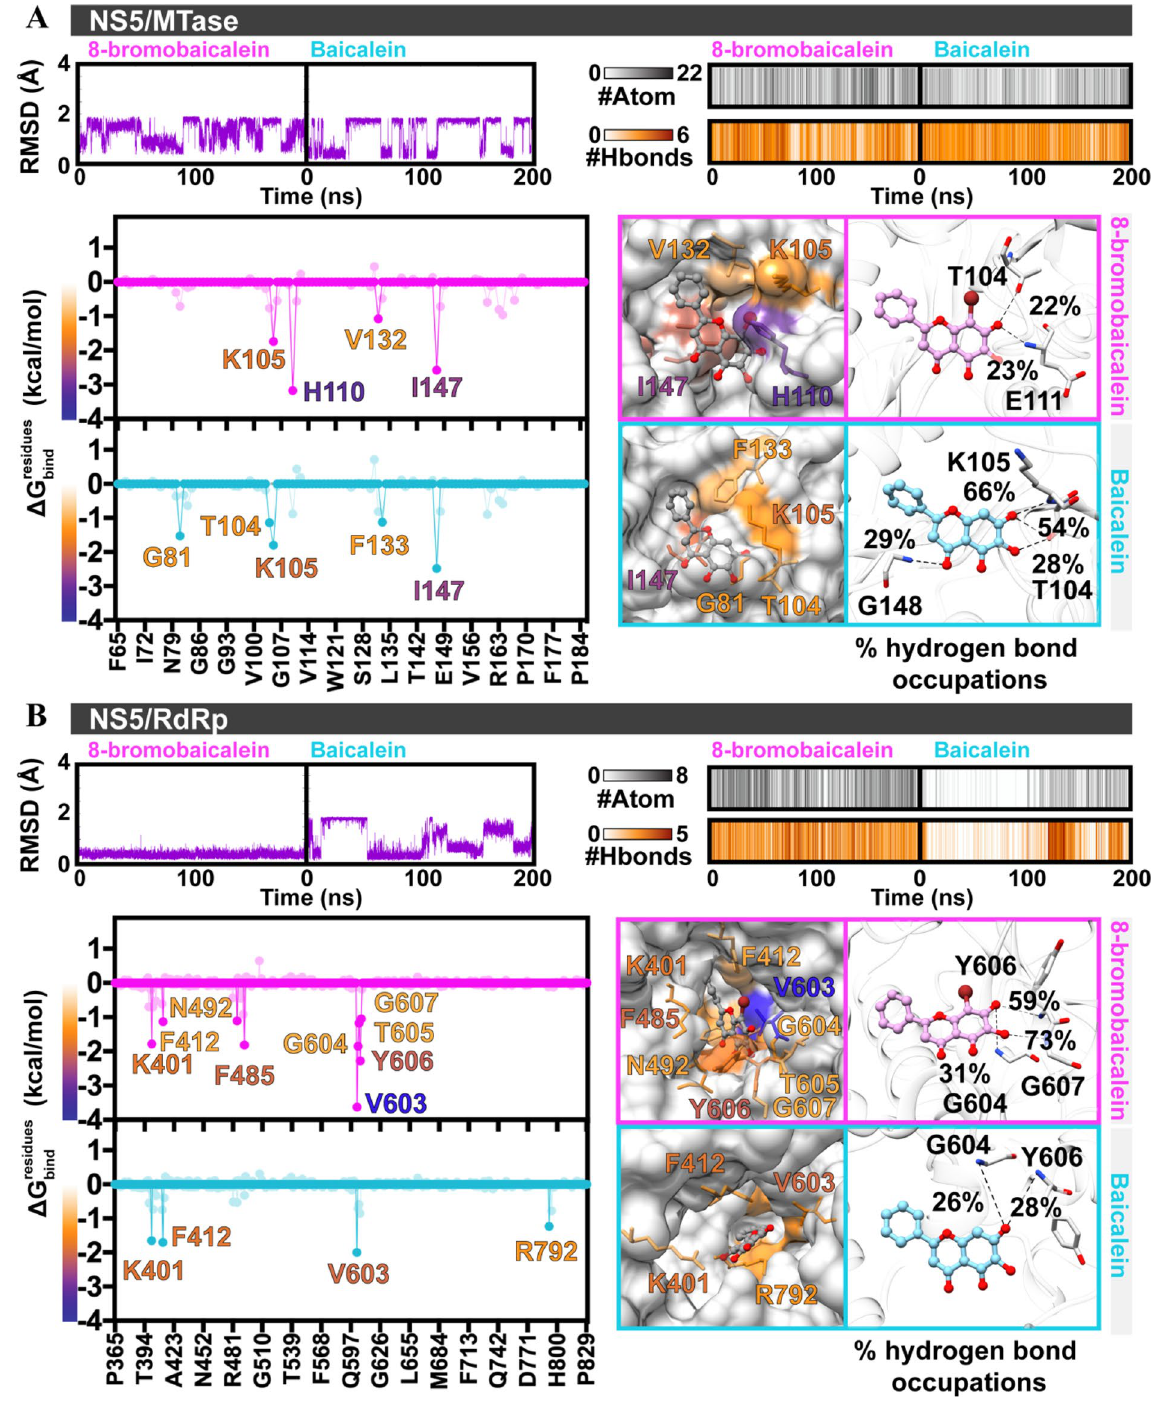
Figure 3. RMSD of ligand atoms, atom contacts (#Atom), number of intermolecular hydrogen bonds (#H-bond), per-residue decomposition free energy ( (cid:31) G baicaleins/MTase and ( B )